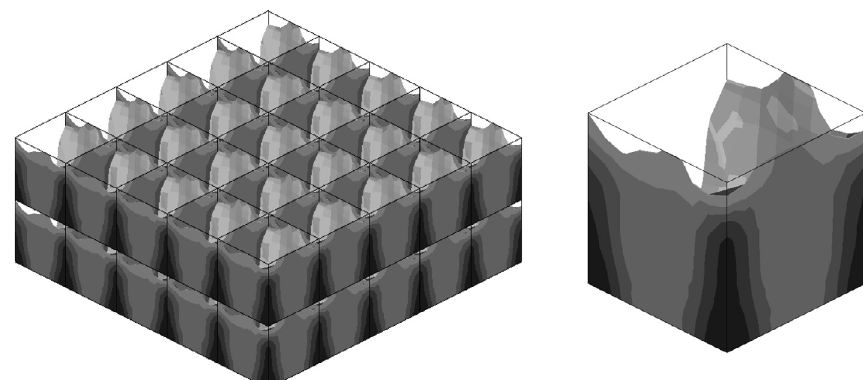
Figure 10. The optimal result obtained with topology